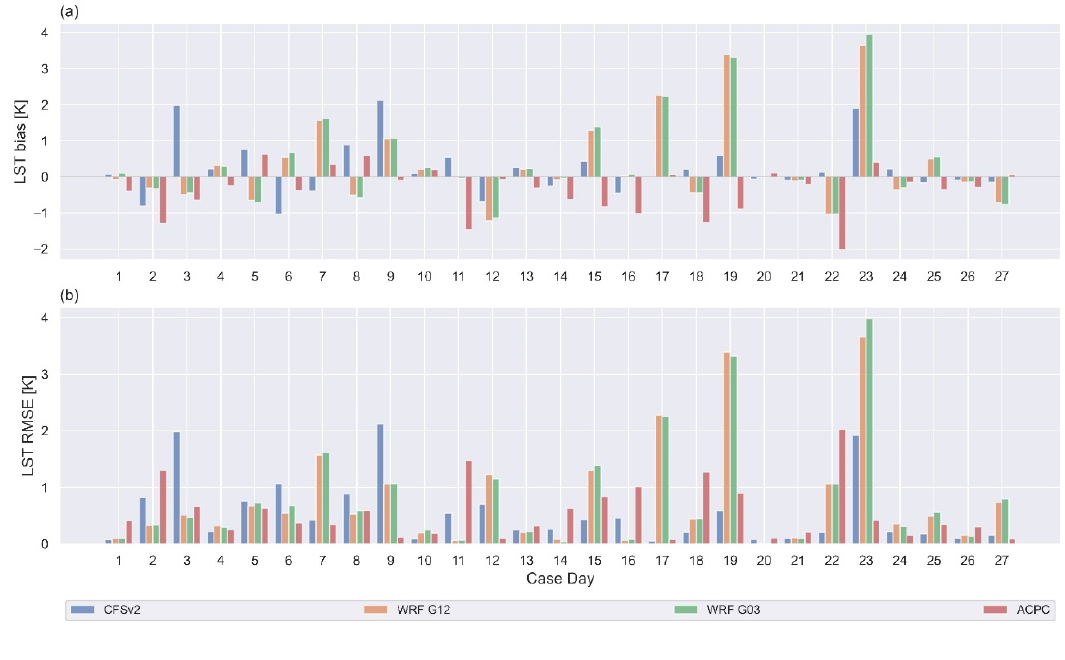
Figure 8. LST ( a ) bias and ( b ) RMSE for each case day.